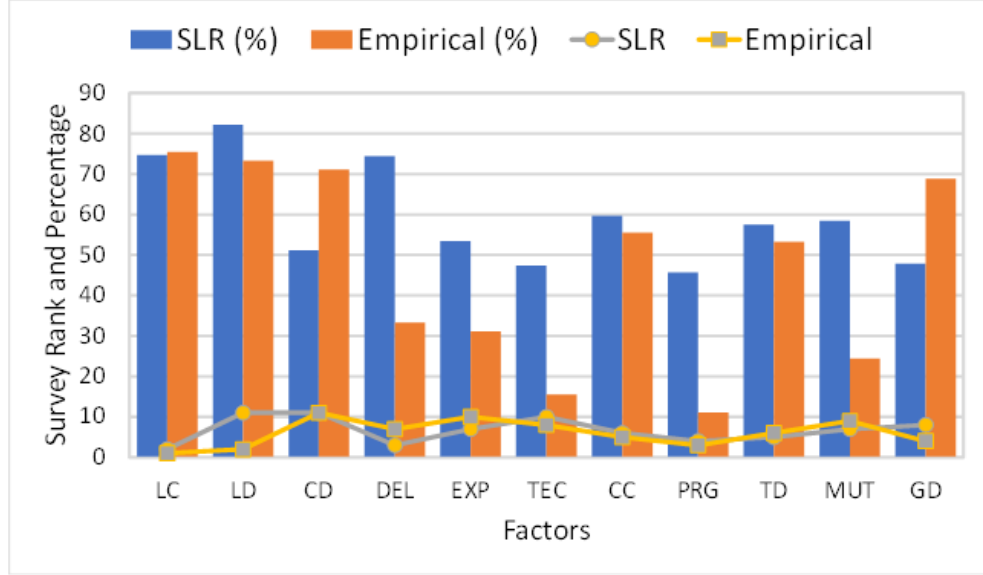
Figure 7. Comparative analysis of SLR and empirical studies